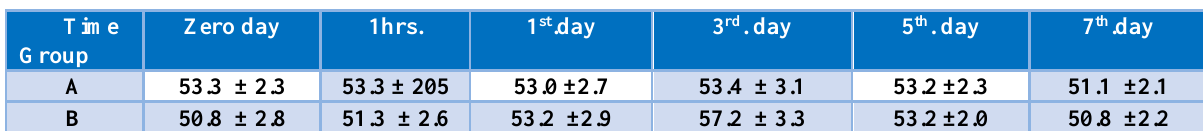
There are no significant differences in the mean values between the different groups A, B and in the different periods. Table, 3: Alanine aminotransferase U/L (ALT) (GPT)